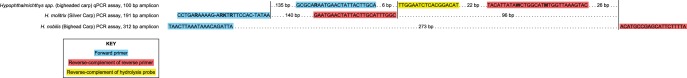
Alignment diagram showing the relative position of oligonucleotides for the qPCR and endpoint PCR assays.The qPCR assay was developed in the present study and the endpoint PCR assays are from a previous study [40]. Gaps (−) and bases in between oligonucleotides (… n bp…) reflect the actual alignment used to design the qPCR assay. Note that all oligonucleotides are shown on the ‘sense’ strand in 5′ to 3′ orientation, left to right. Thus oligonucleotides that actually bind to the sense strand (i.e., reverse primers and the hydrolysis probe) are shown as reverse-complements of the actual oligonucleotides used in an assay (Table 1). Degenerate bases are shown in bold text, but oligonucleotides were not synthesized with degenerate bases for the qPCR assay (Table 1). The forward primer of the Silver Carp endpoint PCR assay was synthesized with degenerate bases, as specified in the study that developed it [40].